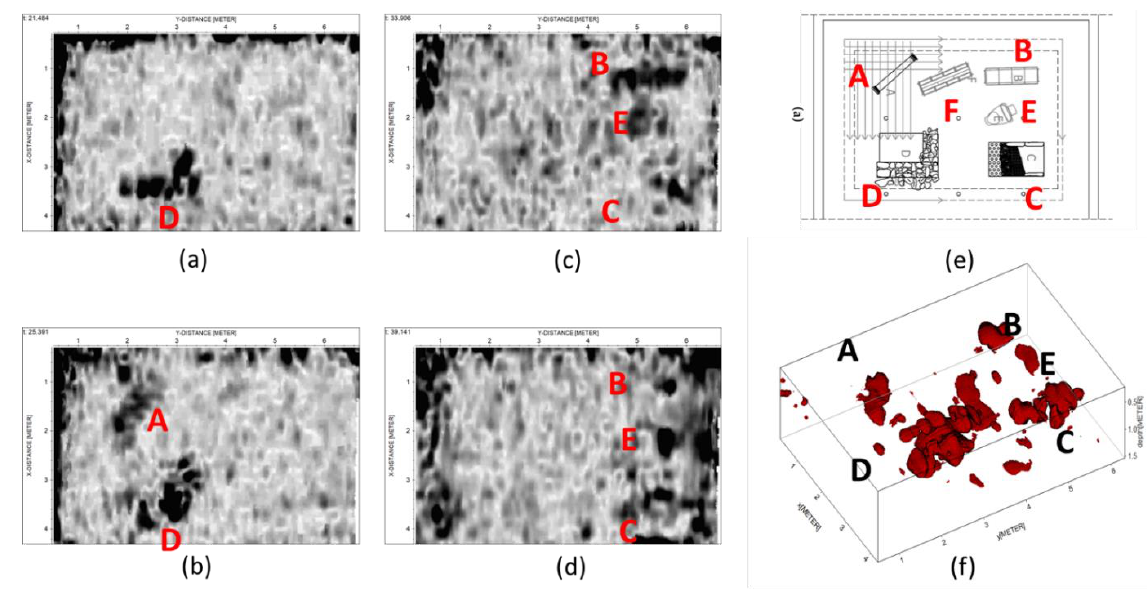
Figure 8. Time-slices at a depth of 0.25 m ( a ), 0.45 m ( b ), 0.70 m, ( c ) and 1.00 m ( d ) with a water table 0.20 m (WL1); ( f ) the 3D iso-amplitude volumes obtained selecting only the highest reflecions and in ( e ) the plane of the test site.